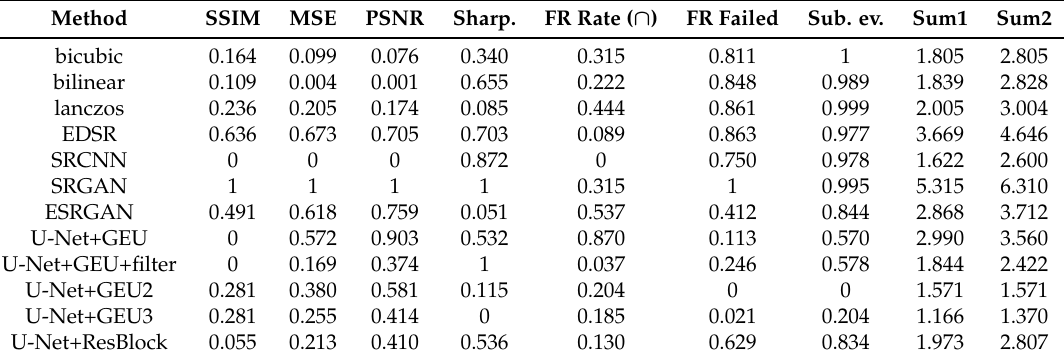
Table 3. Normalized values comparison of all methods to get the final score.